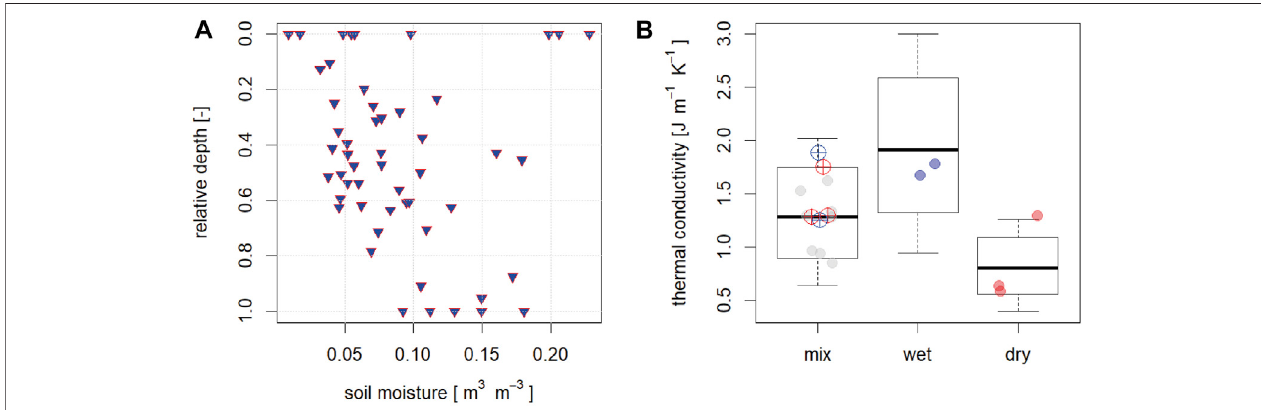
FIGURE 5 | (A) Soil moisture measurements from pits around LIR3. (B) Thermal conductivity calculated using temperature pro fi les and the moisture content. The box plots indicate the range of thermal conductivities as calculated using the range of diffusivities from literature and using the observed moisture range (mix), full saturation (wet) and completely dry debris assumptions (dry). Solid dots are values from literature, transparent crossed dots are calculated with diffusivity and debris moisture only from the observed fi eld data (red — dry, blue —